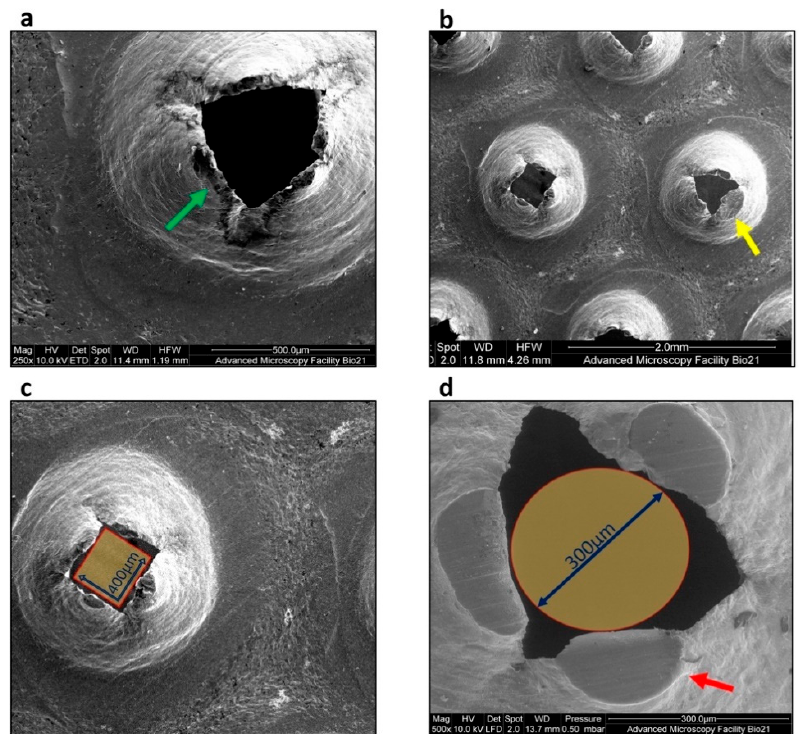
Figure 7. Scanning electron microscope (SEM) observation of the Rigeneracons ® steel grid pores. ( a ) Intact cutting edges of the hexagonal pores (green arrow) in unused disposable device. ( b ) Spread debris was visible after 2 min of processing together with substantial damage of the cutting edges (yellow arrow). Reference scale measurements show the size of random pores after 5 min of processing. Some of the pores measure just slightly over 400 μ m in diameter at the widest span ( c ) and the majority of them allowed the passage of particles with 300 μ m diameter ( d ).